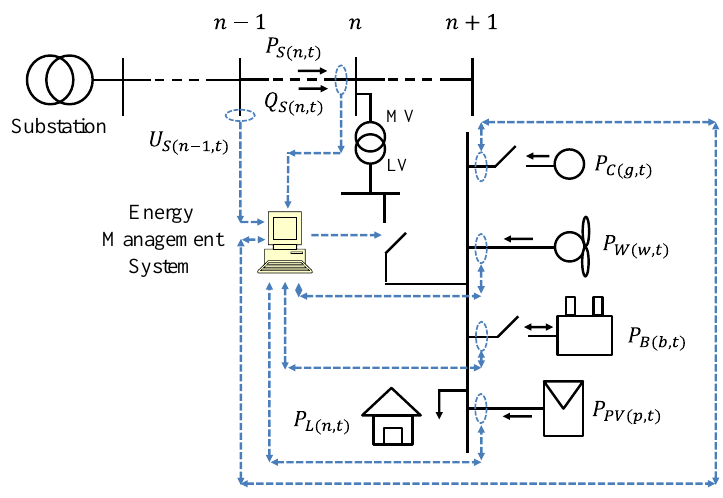
Figure 5. MG structure.